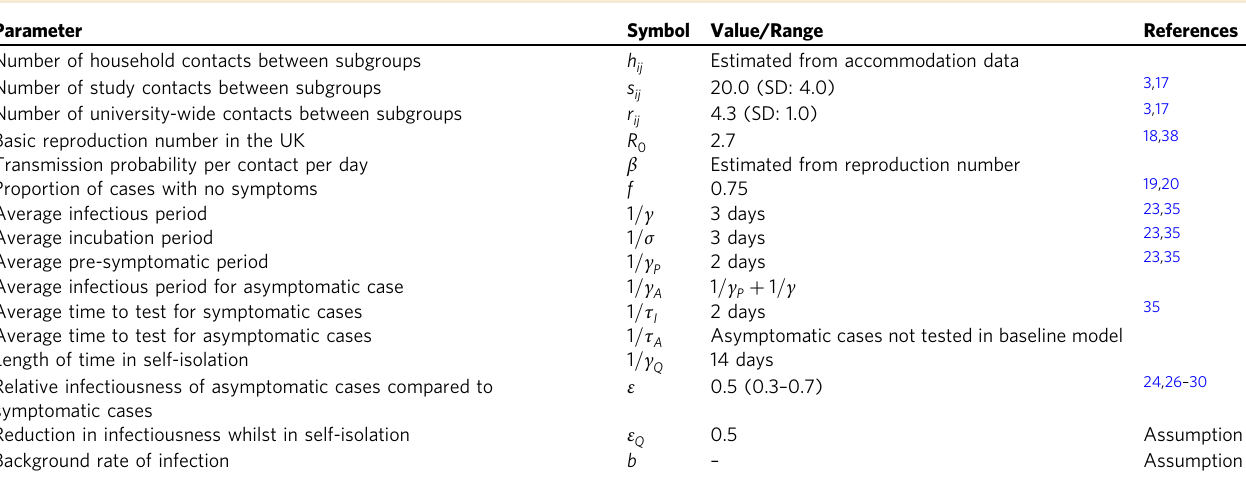
Table 1 Baseline model parameter values, meaning and